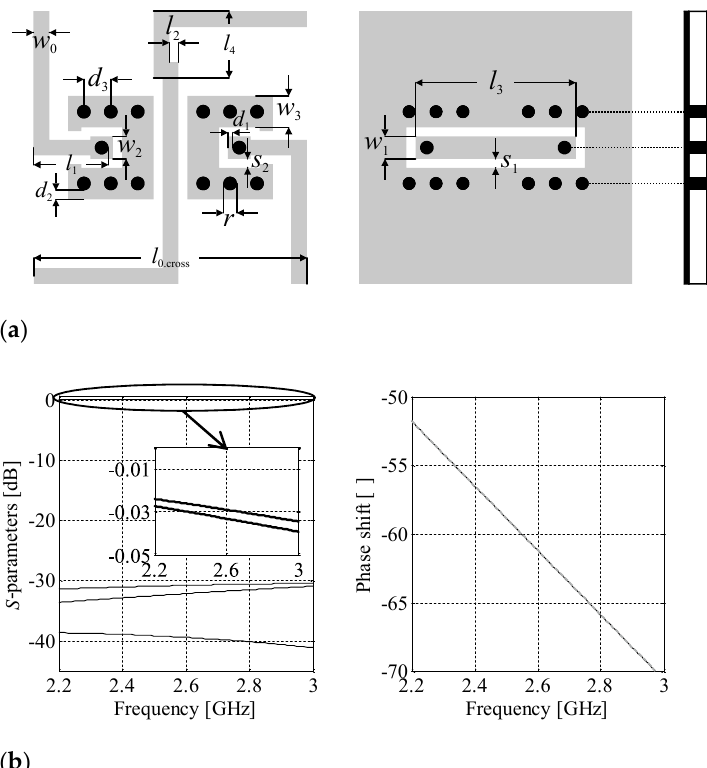
Figure 6. Compact crossover: ( a ) geometry of the structure, as well as ( b ) magnitude and phase characteristics of the circuit obtained based on EM simulations. Note that the electrical lengths of crossed lines (solid gray and dashed black) are virtually the same.